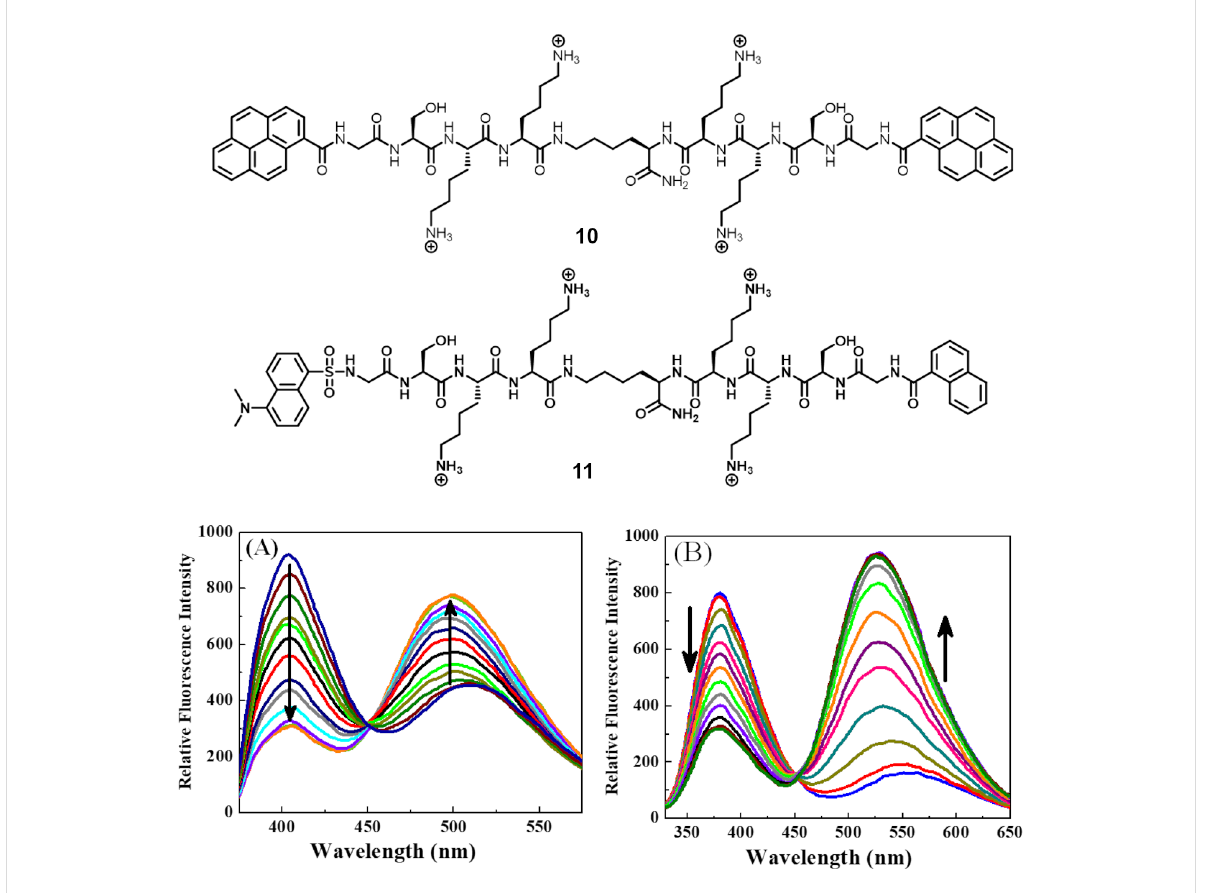
Figure 9: Top: Molecular structures of 10 and 11 ; bottom: A) fluorescence emission spectra of 10 (1.0 µM, λ ex = 340 nm); B) fluorescence emission spectra 11 (1.0 µM, λ ex = 270 nm) with increasing concentration of heparin. Reproduced with permission from [56], Maity, D.; and Schmuck, C., “Fluo- rescent peptide beacons for the selective ratiometric detection of heparin”, Chem. – Eur. J. © 2016 Wiley ‐ VCH Verlag GmbH & Co. KGaA,